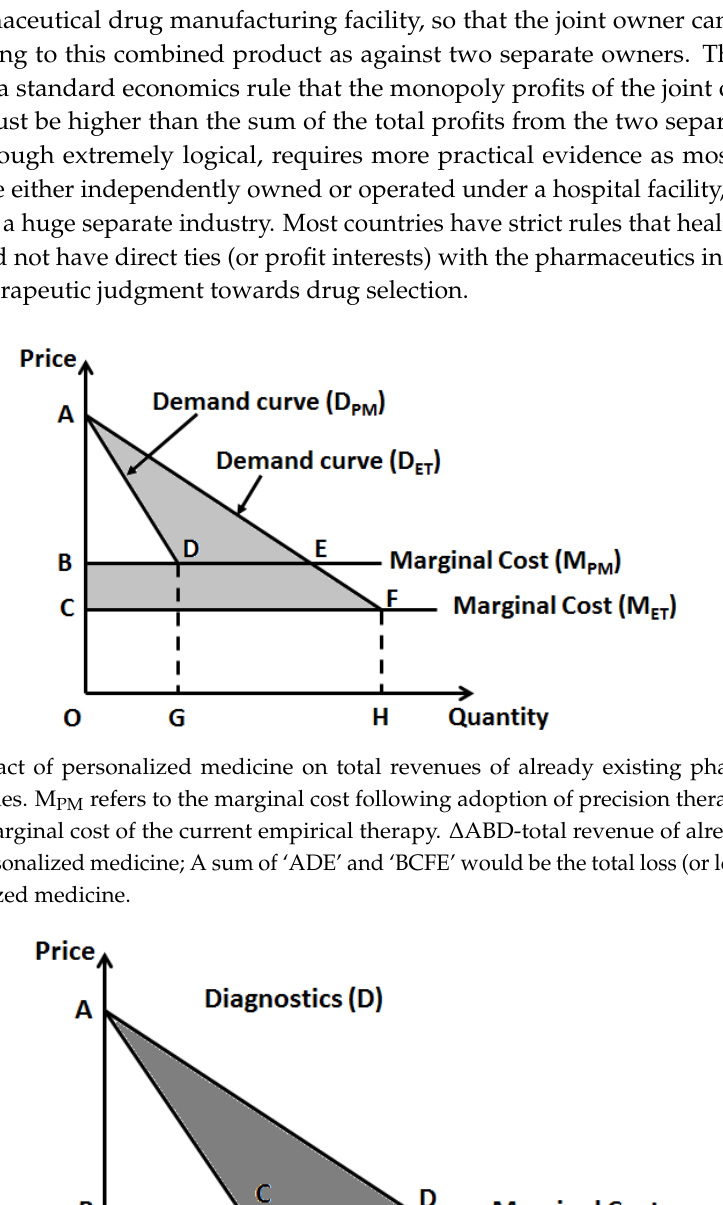
Figure 2. Impact of personalized medicine on total revenues of diagnostic procedures. ΔACD-total additional revenues (or profits) for diagnostic laboratory facilities from personalized medicine.